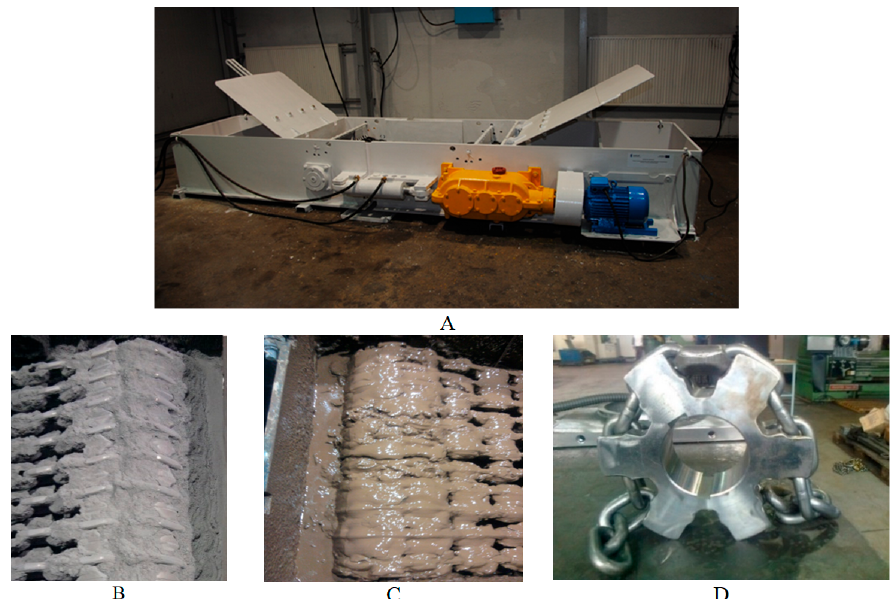
Figure 3. Test rig, ( A )—rig, ( B )—testing chamber filled with dry quartz abrasive, ( C )—testing chamber filled with a mixture of quartz sand and water, ( D )—tested chain wheel.